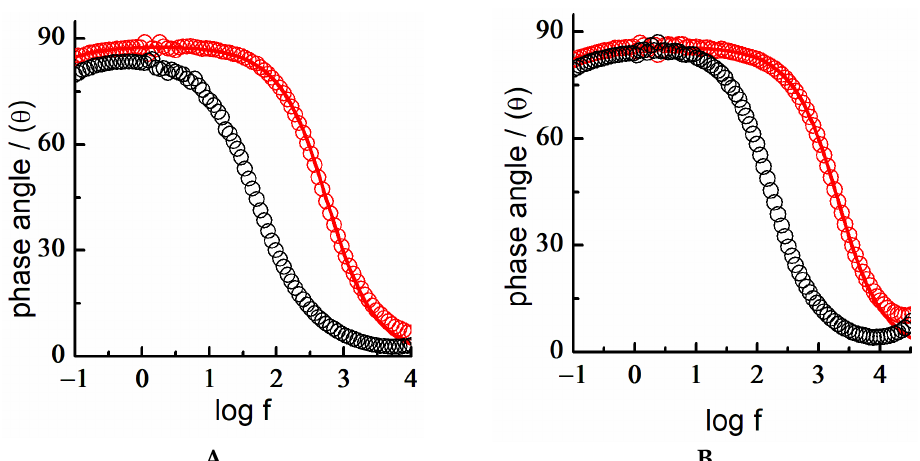
Figure 12. Electrochemical impedance spectra. Bode plot of Au 18K (black circle) and MUA-SAM on Au18K (red circle) in: ( A ) acidic media and ( B ) basic media. Fitting of experimental data to a [R(RQ)] equivalent circuit (red). E = − 0.3 V. Table 5. Equivalent circuits of Au 18K and derivative